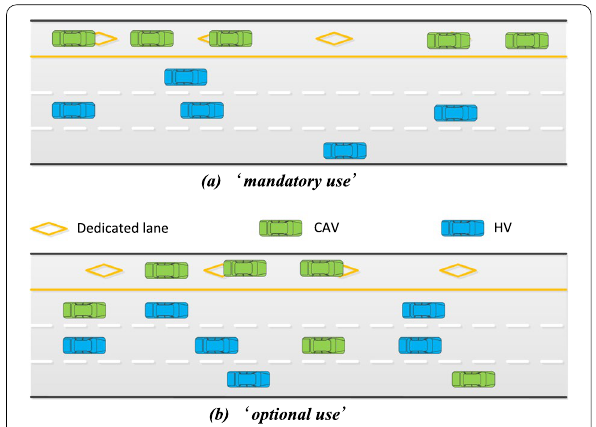
Fig. 1 An illustration for two access control policies of CAV DL